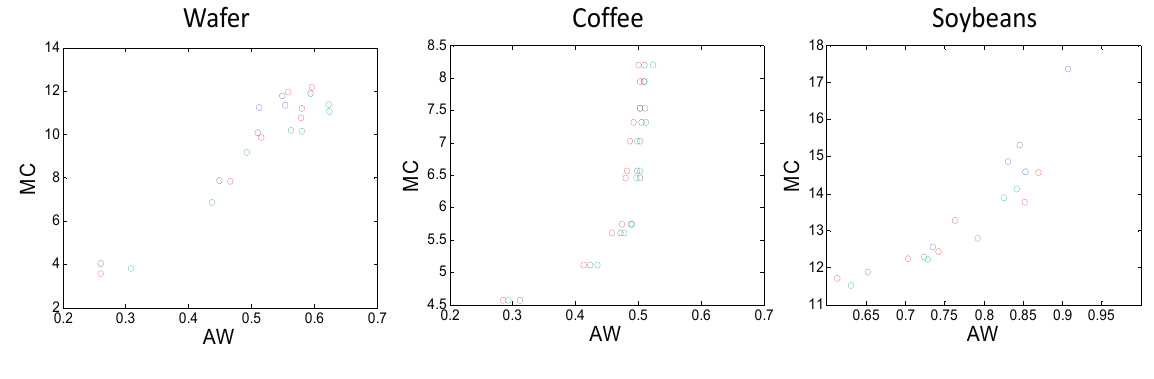
Figure 1. Moisture content (MC) plotted as a function of water activity (aw) for each food sample studied. Different colours represent independent